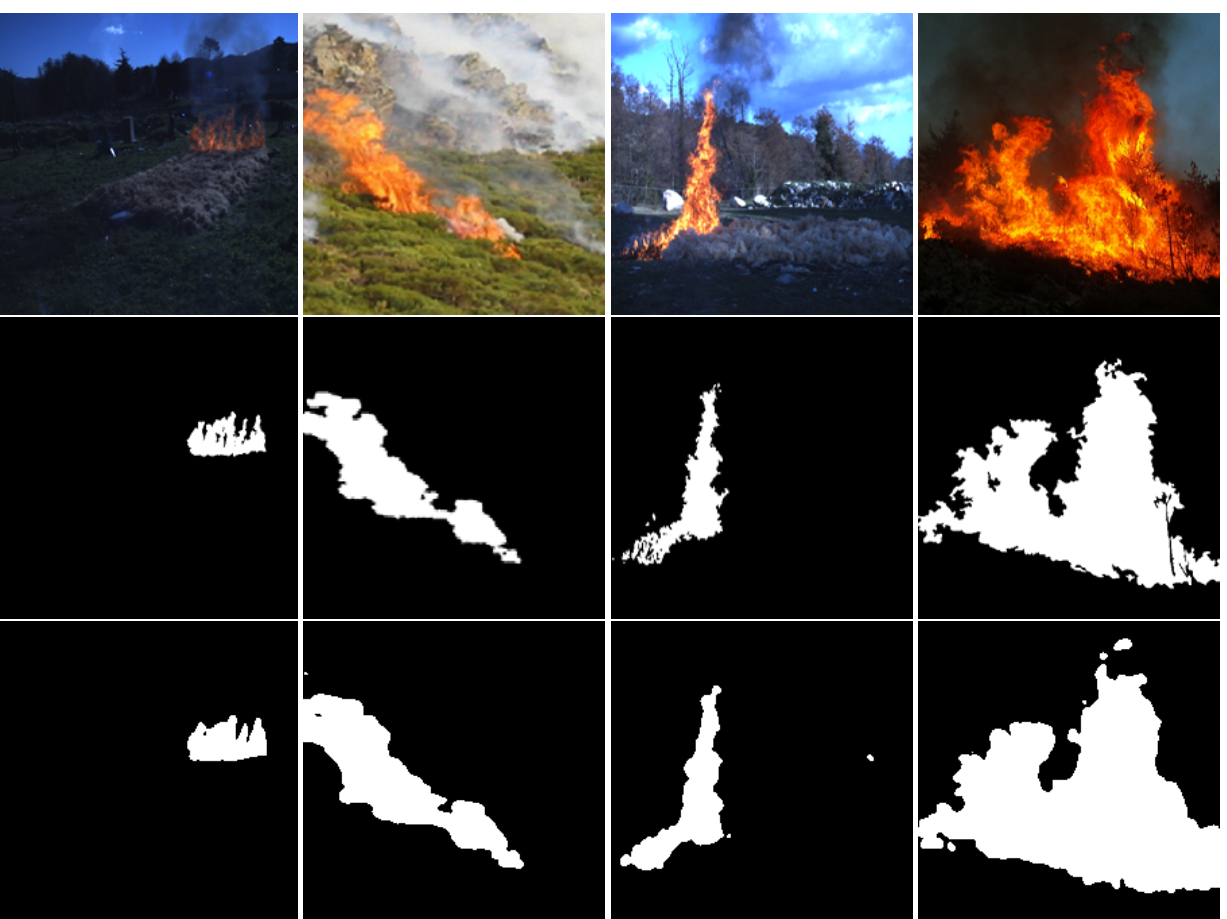
Figure 9. Results of U-Net. From ( top ) to ( bottom ): RGB images, their corresponding mask, and the predicted images of